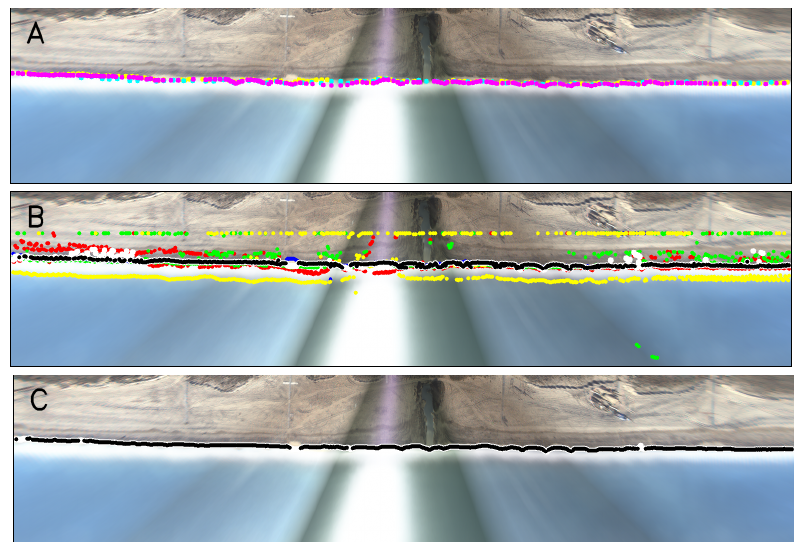
Figure 3. Examples of ( A ) manual shorelines digitized by the three users (in different colors), ( B ) raw shorelines out of the four methods (red, green, blue and yellow) and combined shoreline (white and black) and ( C ) filtered shoreline (white and black) of beach CFA1 on 27 November 2017 at 12 h. In ( B ), the raw shorelines come from Hue gradient (red), Saturation gradient (green), Value gradient (blue) and R/G gradient (yellow). In ( B ), the white points are the combined shoreline, while the points of the combined shoreline where E c < 10 px are in black (Equation (5)). In ( C ), the white points are the filtered shoreline, while the points of the filtered shoreline where E f < 10 px are in black (Equation (9)). Sun glare occurs in the central camera and some areas also show beach cusp presence.